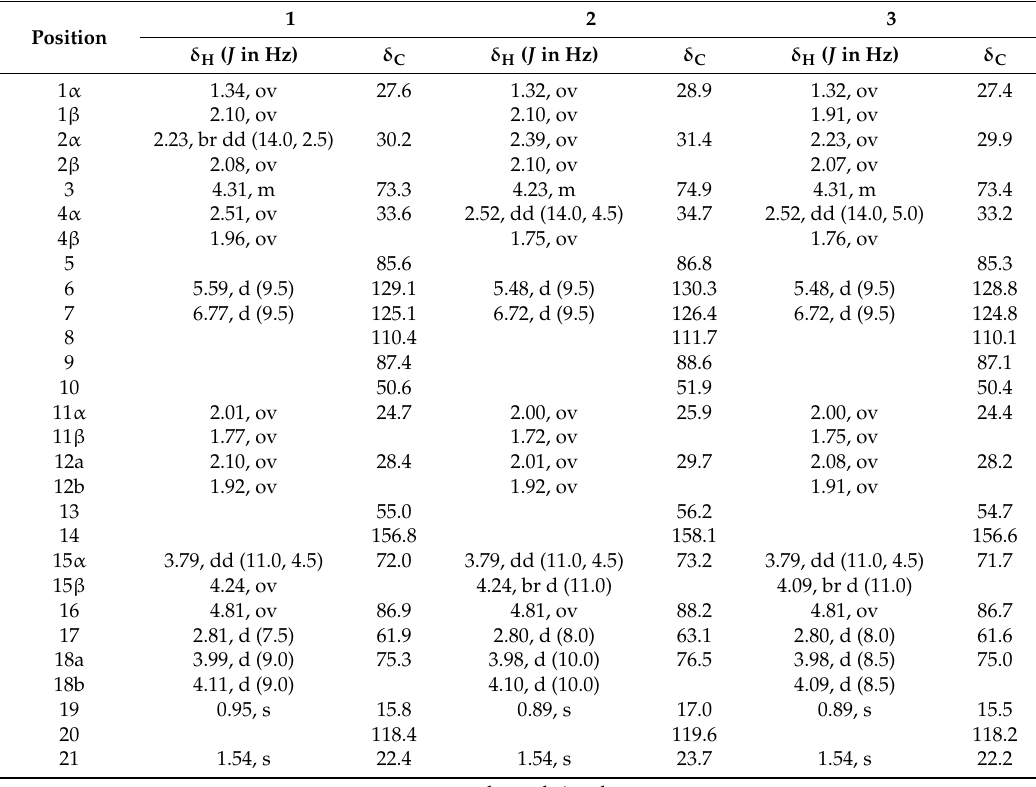
Table 1. 1 H- and 13 C-NMR spectroscopic data for the aglycone moieties of 1 – 3 (in pyridine- d 5 , TMS). 1 Position